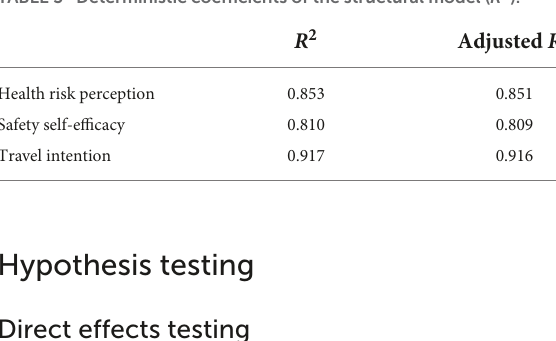
TABLE 3 Deterministic coefficients of the structural model ( R 2 ).